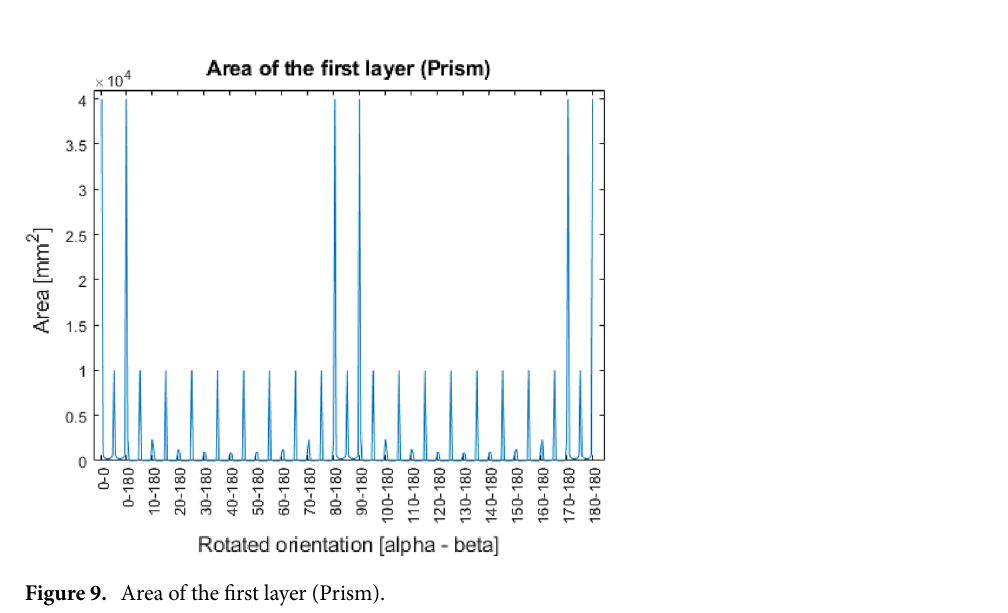
Table 5. Number of slices in the special sphere.